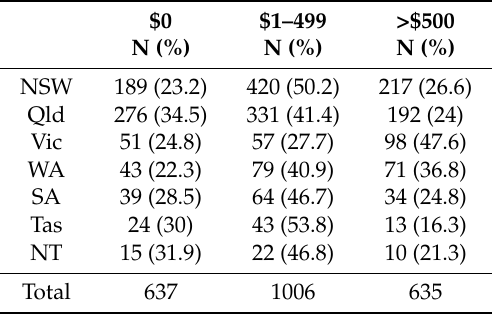
Table 3. Price range (AUS$) of dogs advertised on Gumtree between 7 and 26 February 2016 and their Australian State or Territory. Percentages represent the proportion of dogs within that State/Territory in each price category.